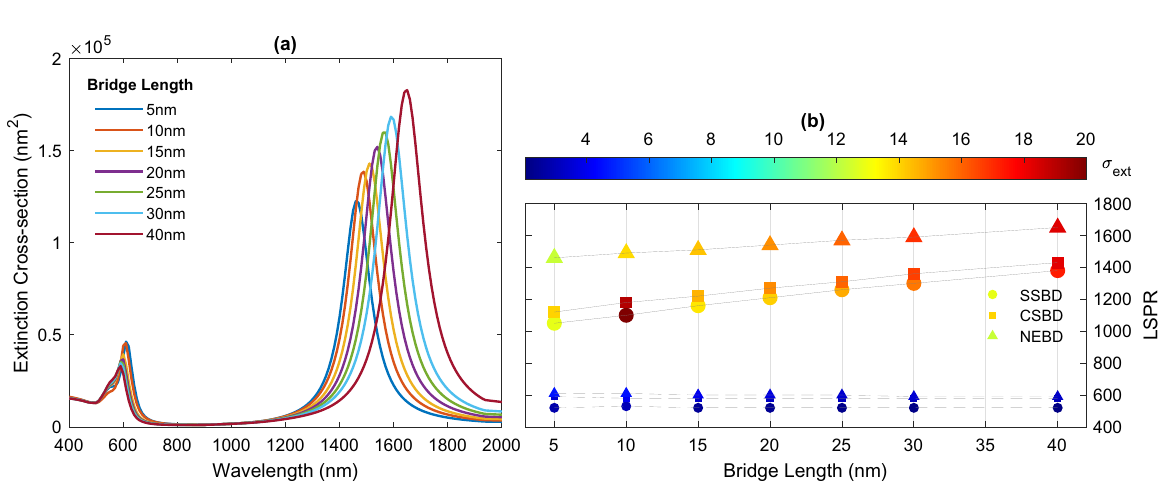
Figure 10. ( a ) Extinction spectra of NEBDs with different bridge length. ( b ) Variation of resonance modes and their intensity by the length of the bridge. Solid and dashed lines relate to CTP and SBDP modes,